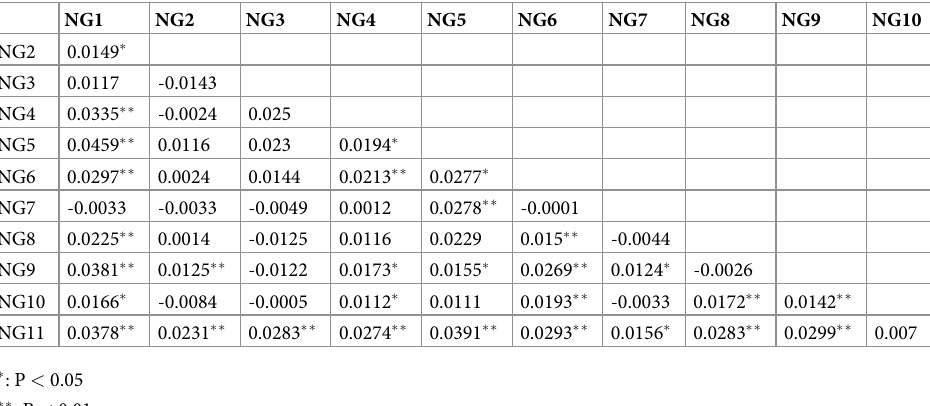
Table 4. Pairwise fixation index values (F st ) between eleven Ae . albopictus populations in